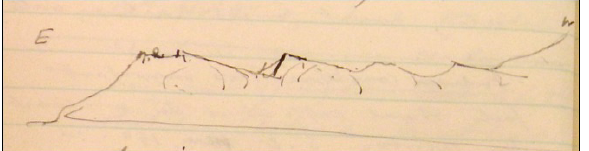
Figure 2: Du Toit’s sketch of the outline of Mahé Island, Seychelles, 25 January 1938, looking towards the south. 7 Three shallow westward-dipping planes represent a former peneplain, which has been downfaulted and rotated by steeply eastward dipping faults, one of which is drawn with a prominent thick line (centre).